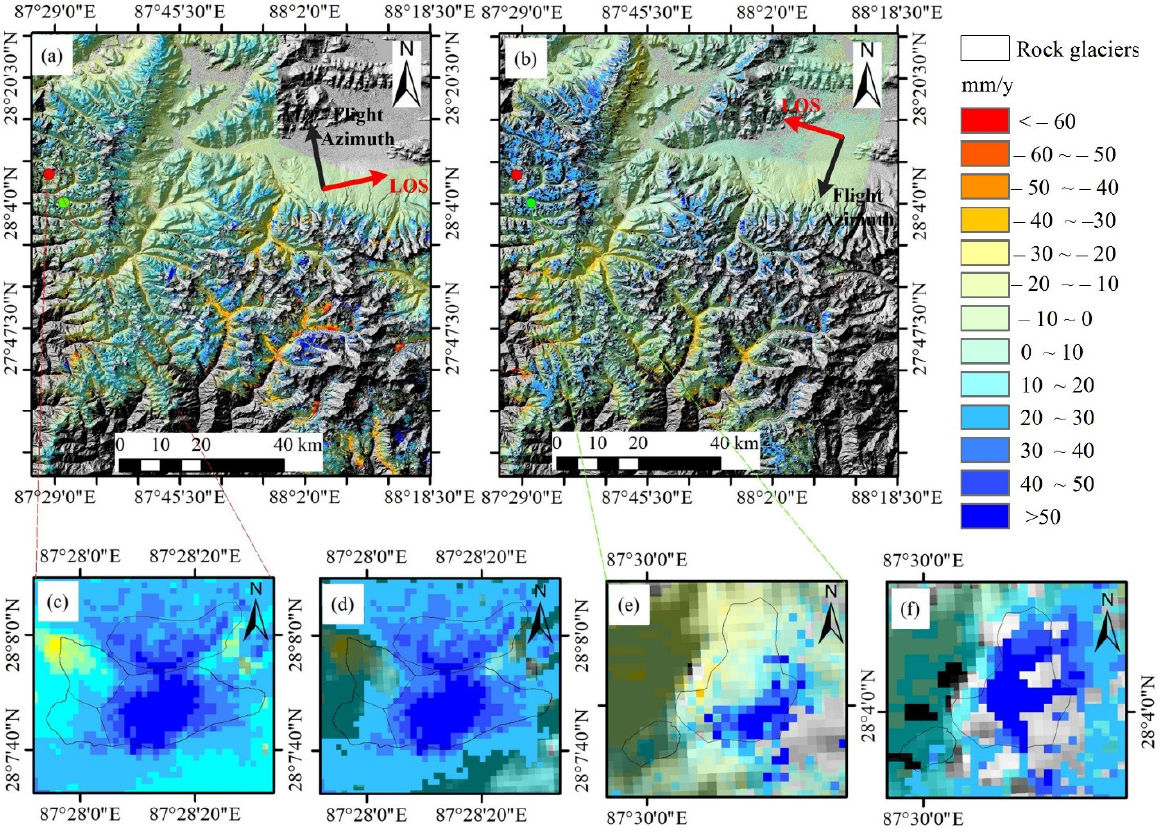
Figure 16. Comparison of deformation estimates from multi-baseline PS–DS network-based MT-InSAR method ( a ) and traditional SBAS method ( b ) in an ROI. ( c , e ) Rock glacier deformations estimated by multi-baseline PS–DS network-based MT-InSAR method. ( d , f ) Rock glacier deformations estimated by the traditional SBAS method.